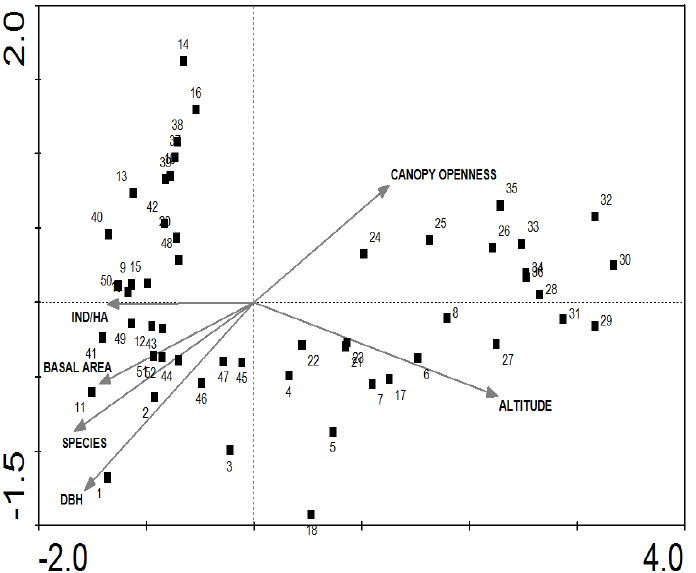
Figure 3. Biplot showing the ordination of 52 sample plots, points show the grouping and the vectors indicate the variables that mostly influenced the